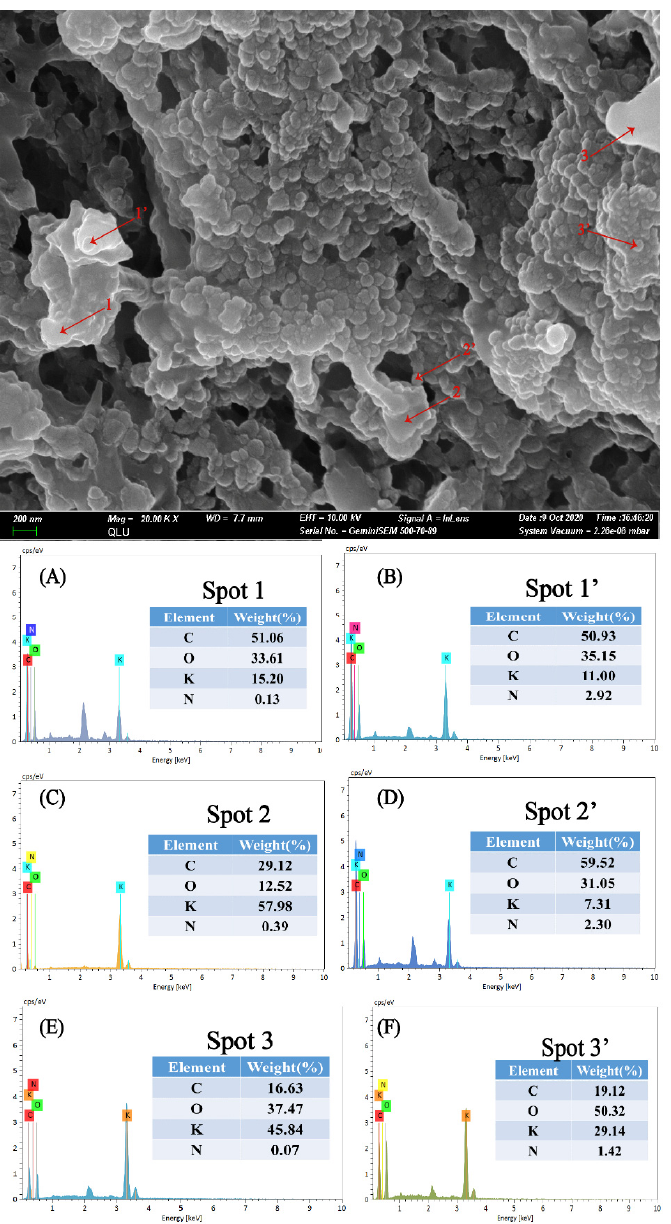
Figure 3. ( A ) The EDX curve of PVA/KOH/QMCC alkaline polymer electrolyte membranes at Spot 1. ( B ) The EDX curve of PVA/KOH/QMCC alkaline polymer electrolyte membranes at Spot 1’. ( C ) The EDX curve of PVA/KOH/QMCC alkaline polymer electrolyte membranes at Spot 2. ( D ) The EDX curve of PVA/KOH/QMCC alkaline polymer electrolyte membranes at Spot 2’. ( E ) The EDX curve of PVA/KOH/QMCC alkaline polymer electrolyte membranes at Spot 3. ( F ) The EDX curve of PVA/KOH/QMCC alkaline polymer electrolyte membranes at Spot 3’.